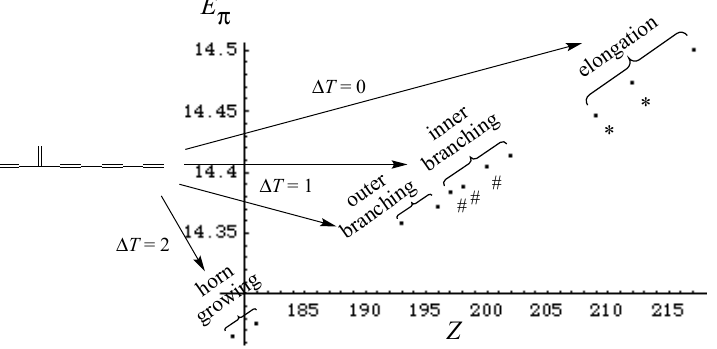
Figure 8. Z – E π plot of eleven isomers of C 12 derived from an isomer of C 10 ( 5* ) showing the four distinctive types of polyene growing. See the later discussion on the marks * and #.